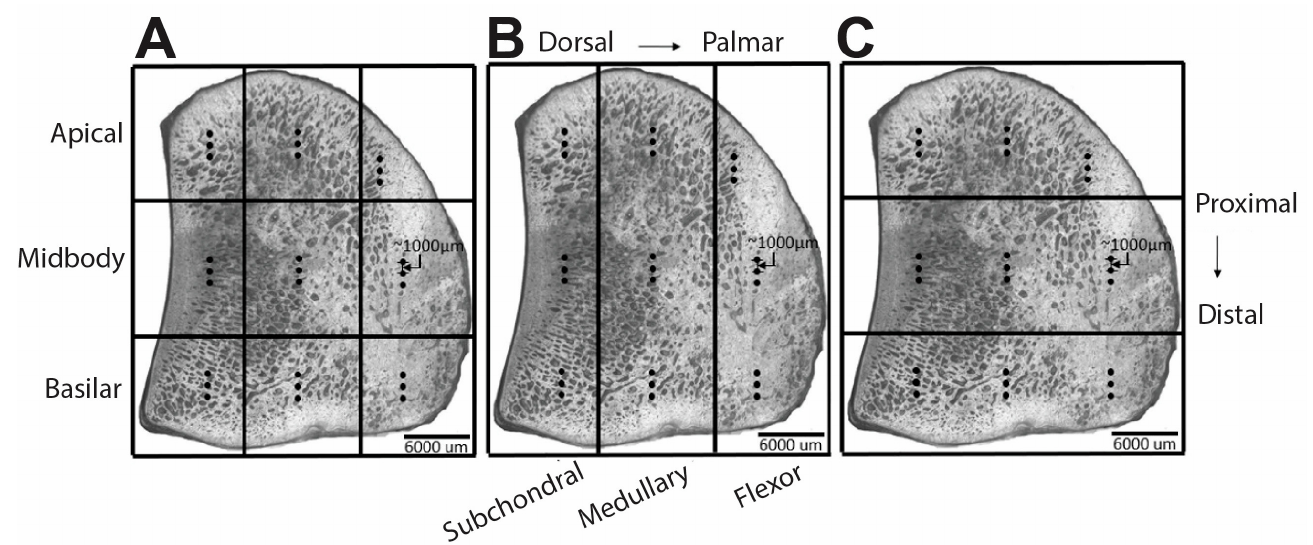
Figure 1. Representative optical micrographs of the mid-sagittal plane of the proximal sesamoid bone showing the 9 regions into which each specimen was subdivided for regional analysis by Raman spectroscopy. Three spectra (represented by solid circles) were collected within each region. ( A ) nine rectangular regions with a 3 × 3 grid layout; ( B ) three dorsal-palmar regions; ( C ) three proximal-distal regions.